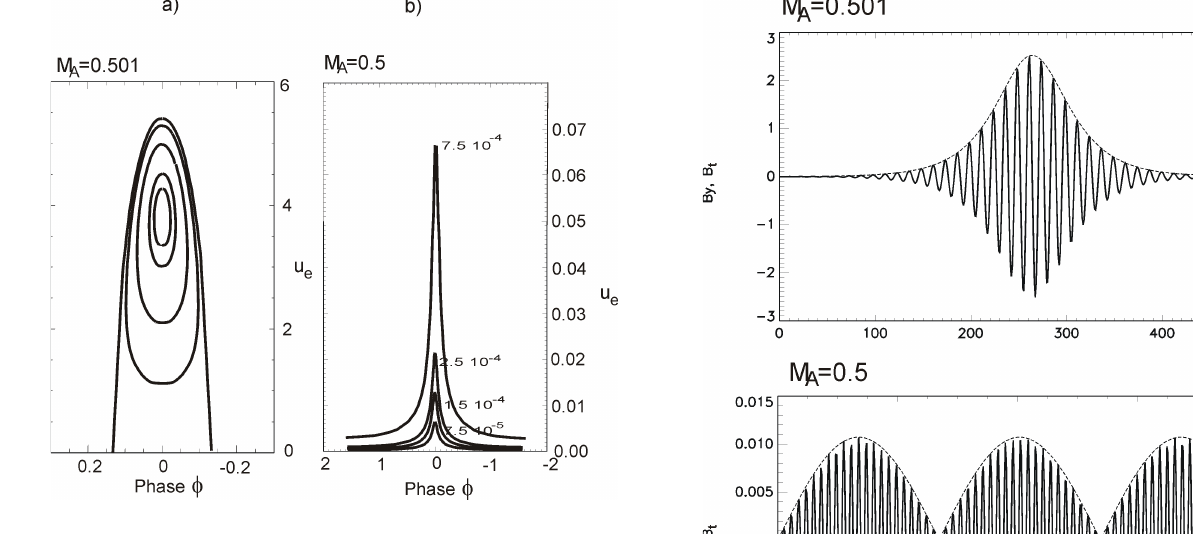
Fig. 10. (a) Phase portrait of solitary and periodic nonlinear whistler solutions in the variables u e ,φ . (b) Phase portrait of the solutions in the form of periodic wave packets at M Ae = 1 / 2.